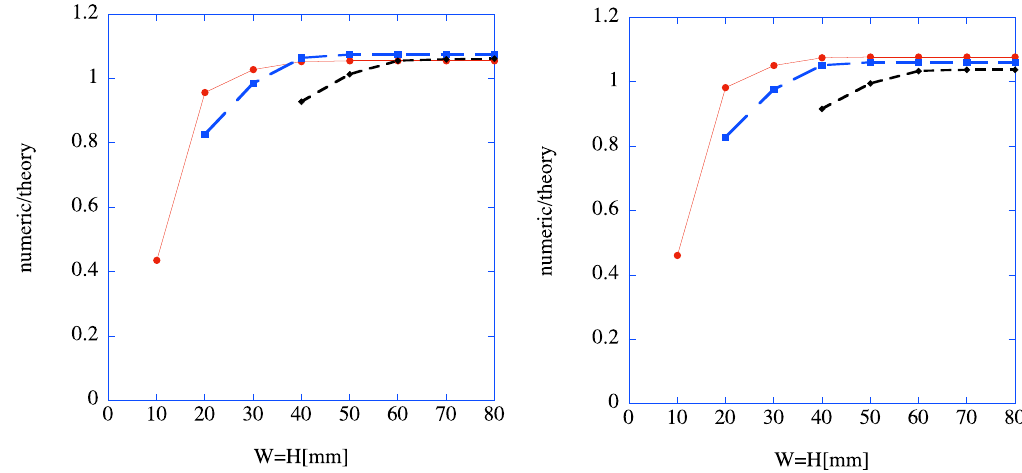
FIG. 6. (Color) The dependence of loss factor on the size of cavity. The vertical axis represents the ratio of the loss factor calculated by numerical calculation to that by the present theory [obtained from Eq. (17)]. The horizontal axis shows the value of W (cid:4) H . The size is chosen to be 1 cm. The left and the right figures represent the a (cid:4) 3 : 5 and a (cid:4) 5 cm cases, respectively. The red, of the beam (cid:3) s blue, and black lines show g (cid:4) 8 , g (cid:4) 16 , and g (cid:4) 32 mm cases, respectively. Roughly speaking, the loss factor of the cavity saturates to that of the gap when the size of the cavity W (cid:4) H exceeds twice the size of the gap.